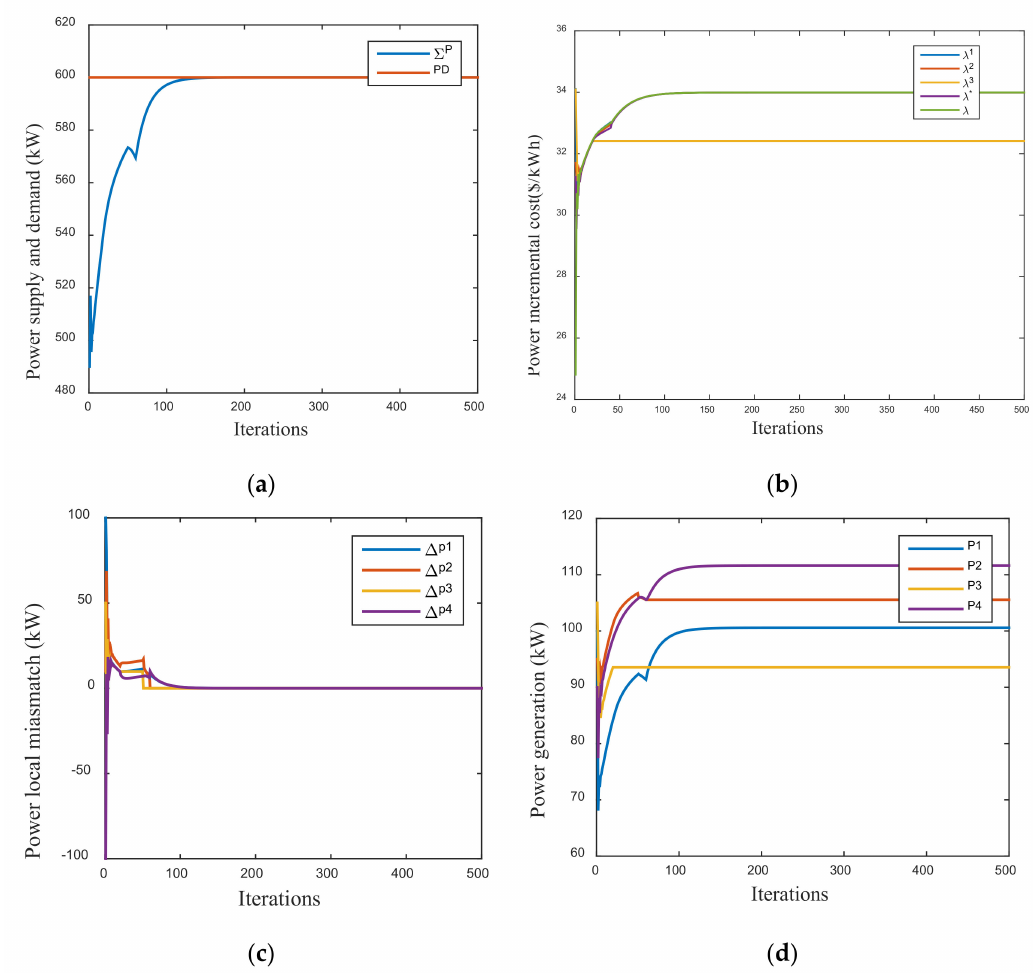
Figure 12. The process of economic dispatch with the robust strategy under the colluding attacks; they should be listed as: ( a ) Total system power output; ( b ) Incremental cost; ( c ) Estimated local power mismatch; ( d ) Output